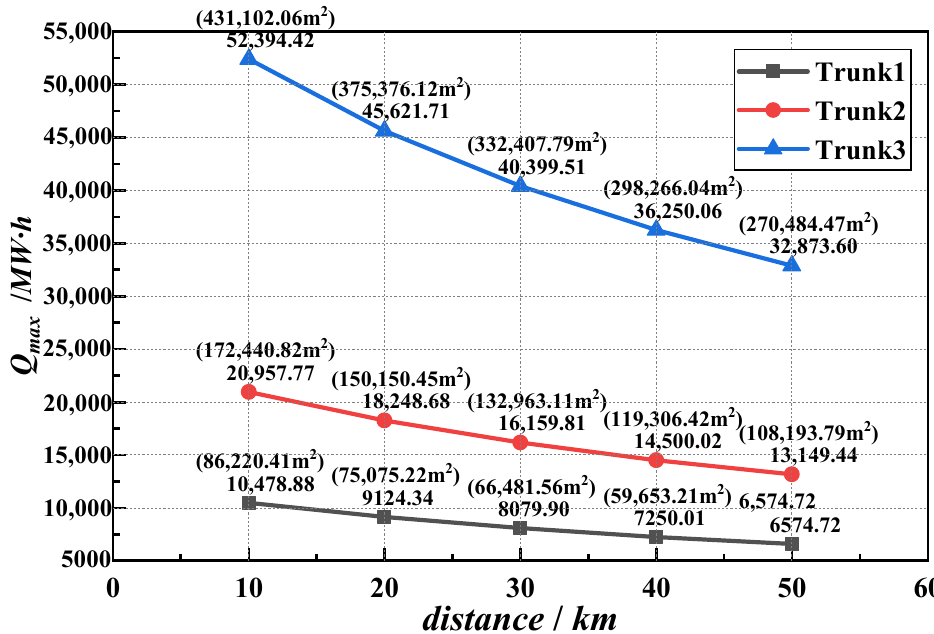
Figure 7. The maximum heating capacity varies with distance under different vehicle types.